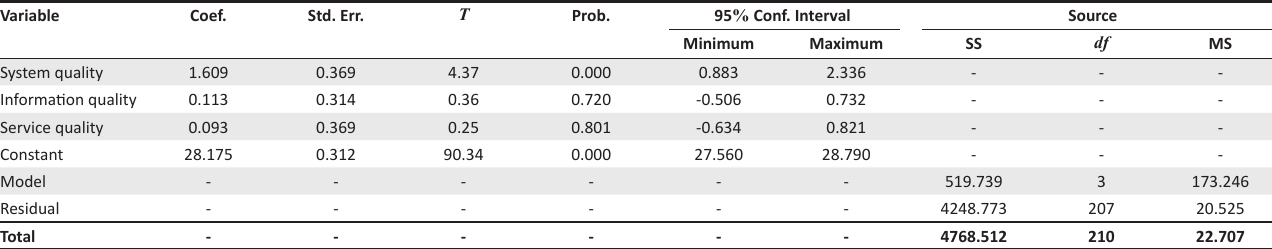
TABLE 6: Regression model for net benefits (without user satisfaction). Variable Coef.